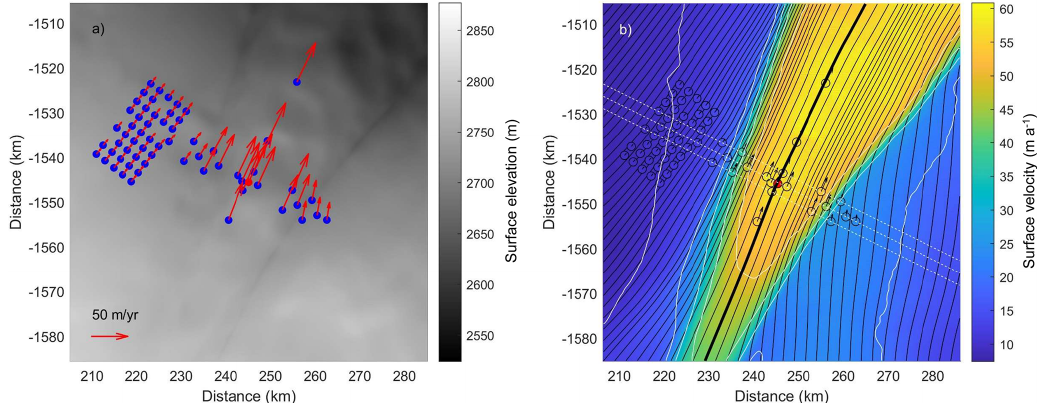
Figure 2. Maps of an 80km × 80km area around the EastGRIP site showing the GPS stake network (blue dots or circles), the central reference stake at the EastGRIP site (red dot), and the GPS-derived surface velocities (red or black arrows) on an underlying map: (a) detailed surface elevation map (m) from ArcticDEM (Porter et al., 2018) with a velocity scale bar and (b) MEaSUREs Multi-year Greenland Ice Sheet Velocity v1 product (ma − 1 ; Joughin et al., 2016, 2018a) with velocity contours and flow lines. The central flow line through EastGRIP is marked (black line). Ice flow and surface elevations along the central flow line A–A (cid:48) (black) and the three transverse lines B–B (cid:48) (white) are shown in Figs. 3 and 4, respectively. Figure 8 shows additional maps of the